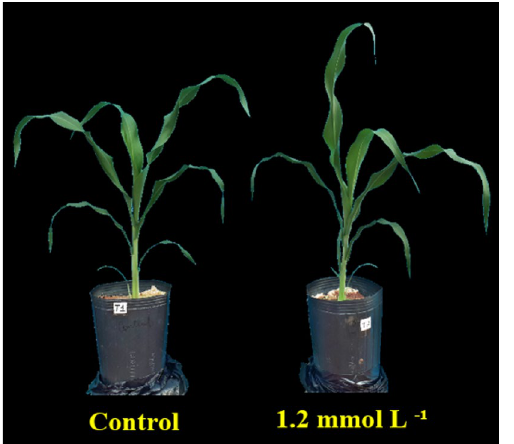
Figure 5. Grain sorghum plants cultivated with nutrient solution without Si (control) and with Si (1.2 mmol L −1 ) in pots filled with sand at 75